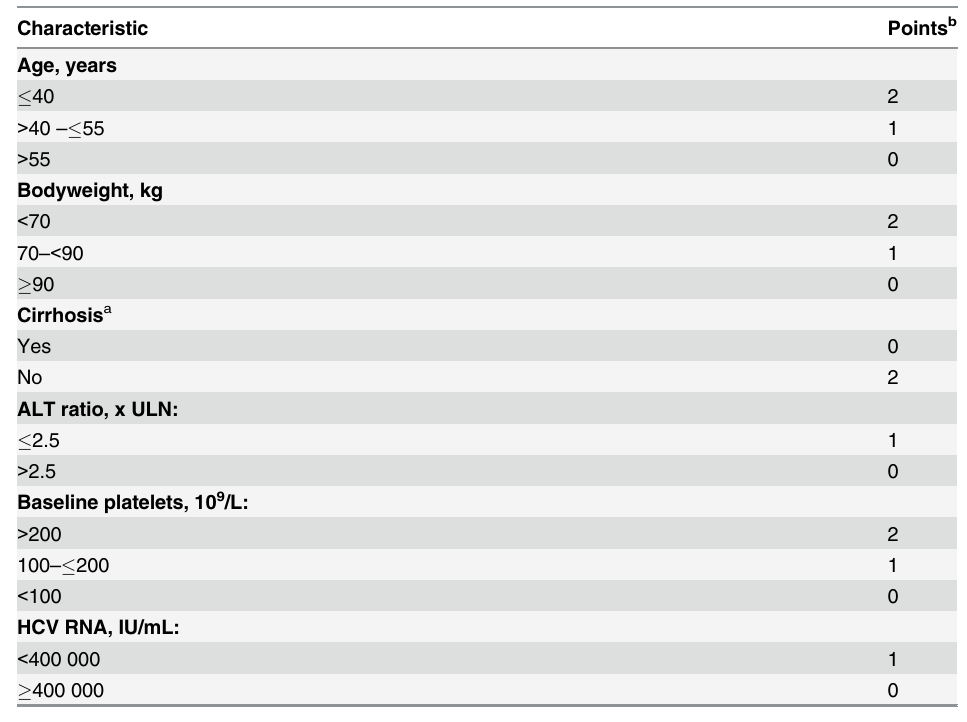
Table 2. Scoring system for predictive baseline